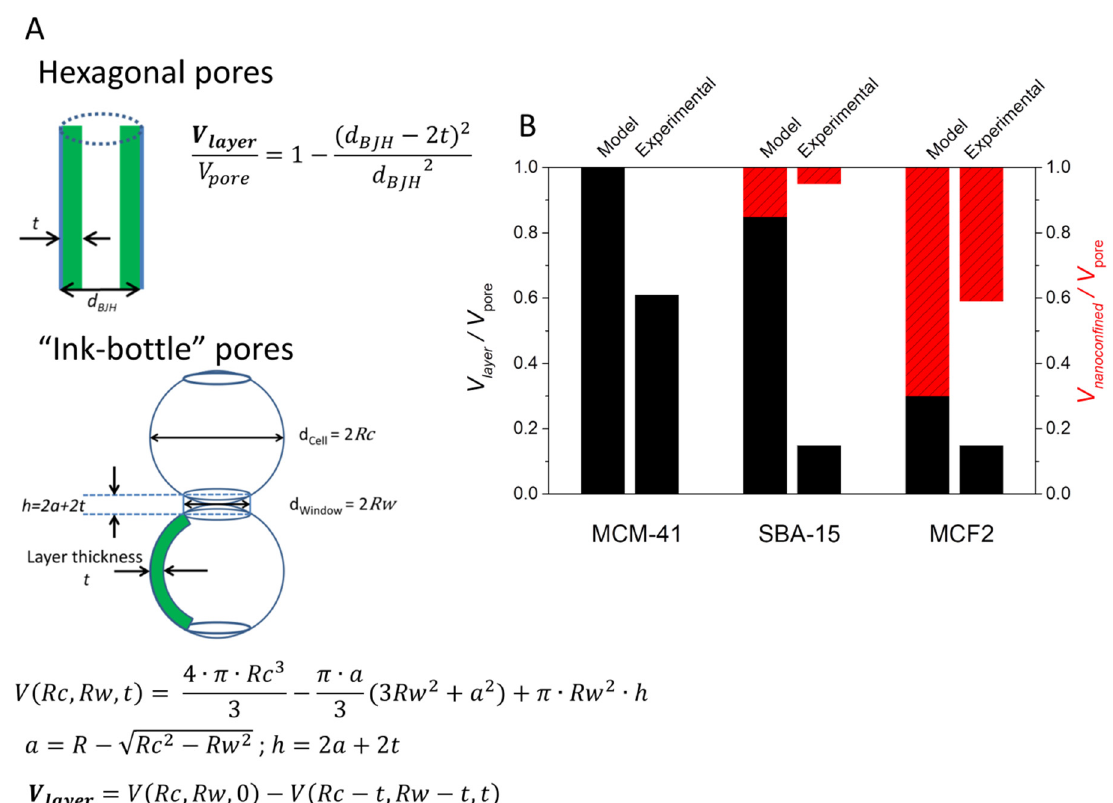
Figure 5. ( A ) Non-melting layer volume model based on porosity data and ( B ) comparison between the experimental and model volumes of the nanoconfined and non-melting phases in the case of NaNO 3 /KNO 3 eutectic. Adapted with permission from ref. [74].